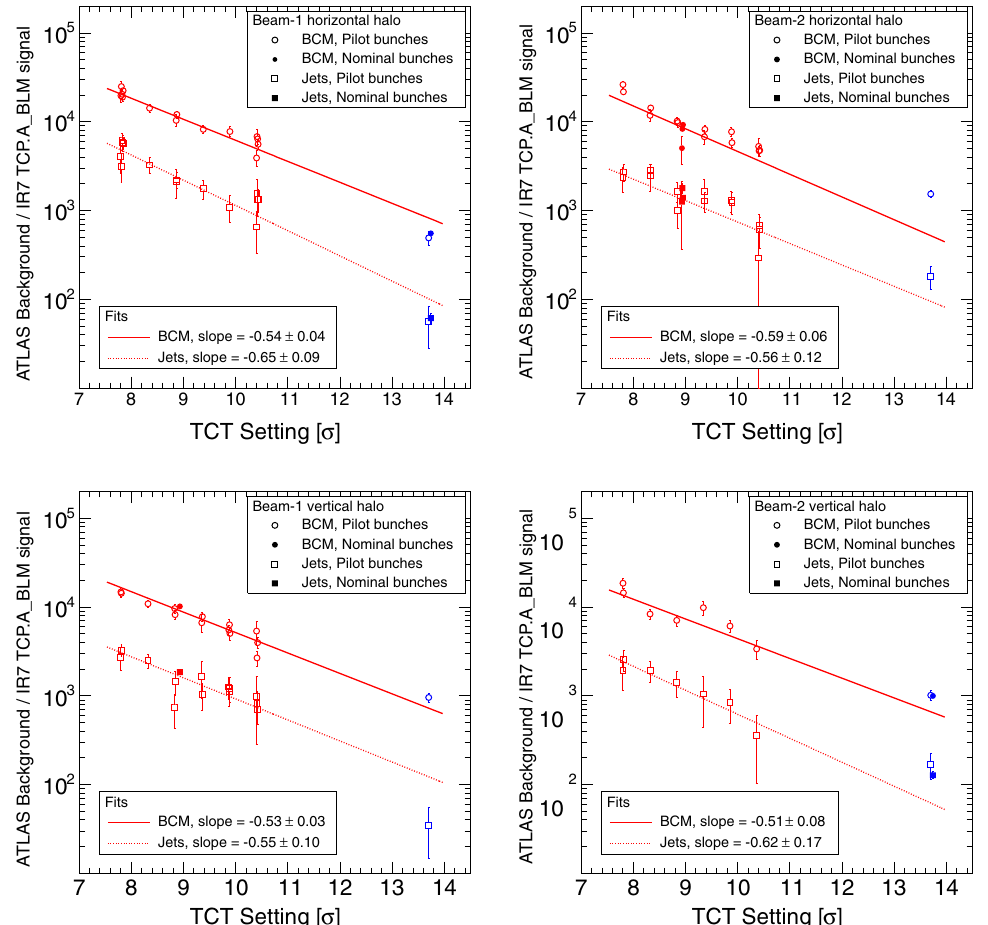
FIG. 5. Ratio between background rates measured by ATLAS and the signal from the TCP BLMs in IR7 for losses provoked on B1 (left) and B2 (right) in the horizontal (top) and vertical (bottom) planes. The red symbols correspond to the β (cid:1) ¼ 40 cm test with TCT settings varied from 7.8 to 10 . 3 σ . The blue points at 13 . 7 σ correspond to the β (cid:1) ¼ 80 cm test. When several measurements fall on the same TCT setting, the points are slightly shifted in the plot in order to separate their error bars. The lines show exponential fits to the β (cid:1) ¼ 40 cm points, of the form Ce ð s × A Þ , where A is the TCT aperture. The ATLAS data are taken from Ref.